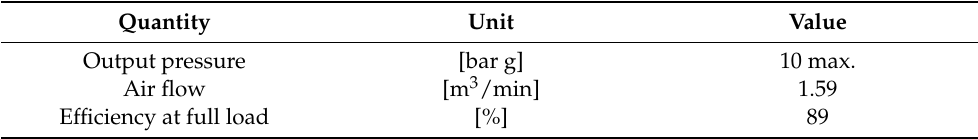
Table 4. Technical data of the air compressor.